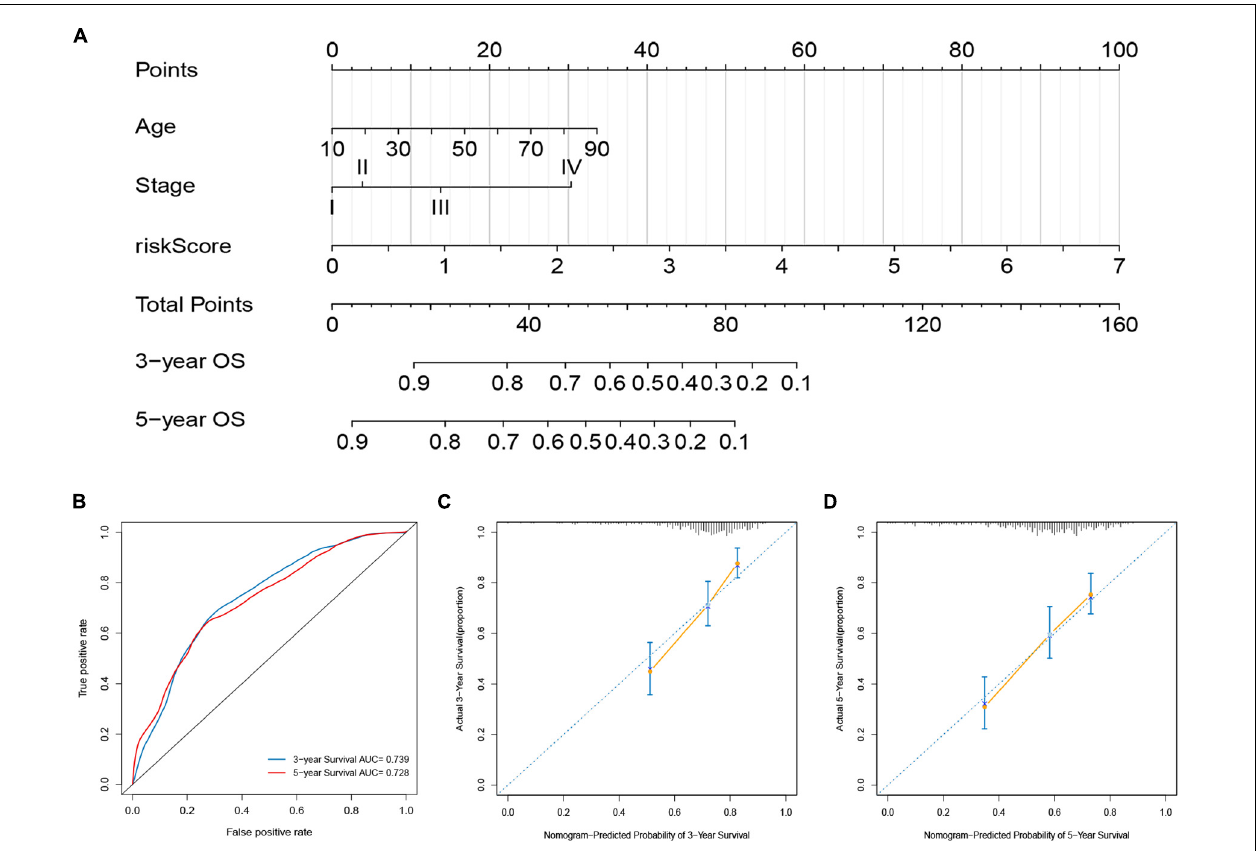
FIGURE 8 | Construction and evaluation of a nomogram for survival prediction of melanoma patients based on risk score and clinical variables. (A) The nomogram was developed for predicting the 3- and 5-year OS of melanoma patients. (B) ROC curves for 3- and 5-year OS of the nomogram. (C,D) Calibration curves for predicting 3- and 5-year